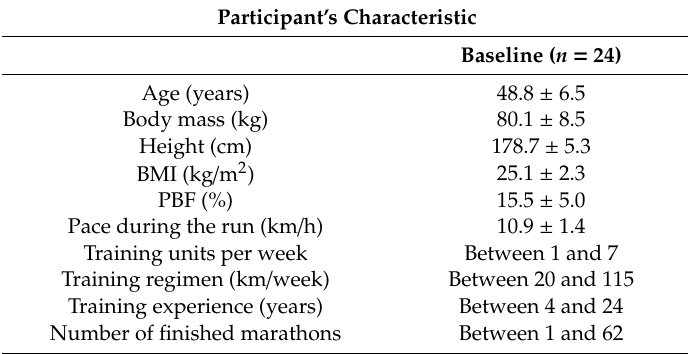
Table 1. Characteristic of the participants. Data are presented as a range or means ± standard deviation